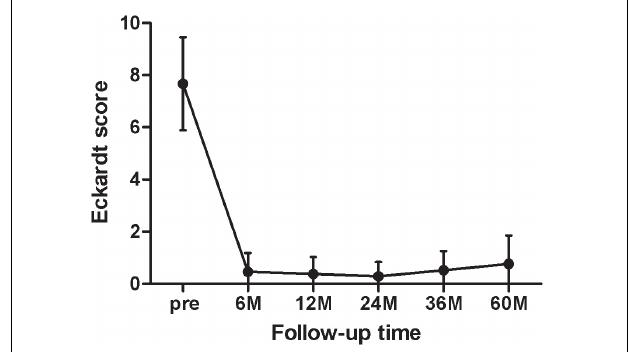
FIGURE 2 | The mean of the Eckardt score at each follow-up point (6, 12, 24, 36, and 60 months).